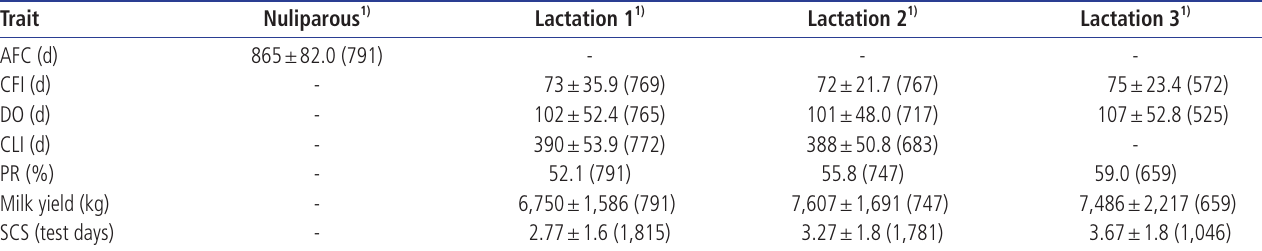
Table 1. Descriptive statistics for reproductive traits, milk yield and somatic cell count